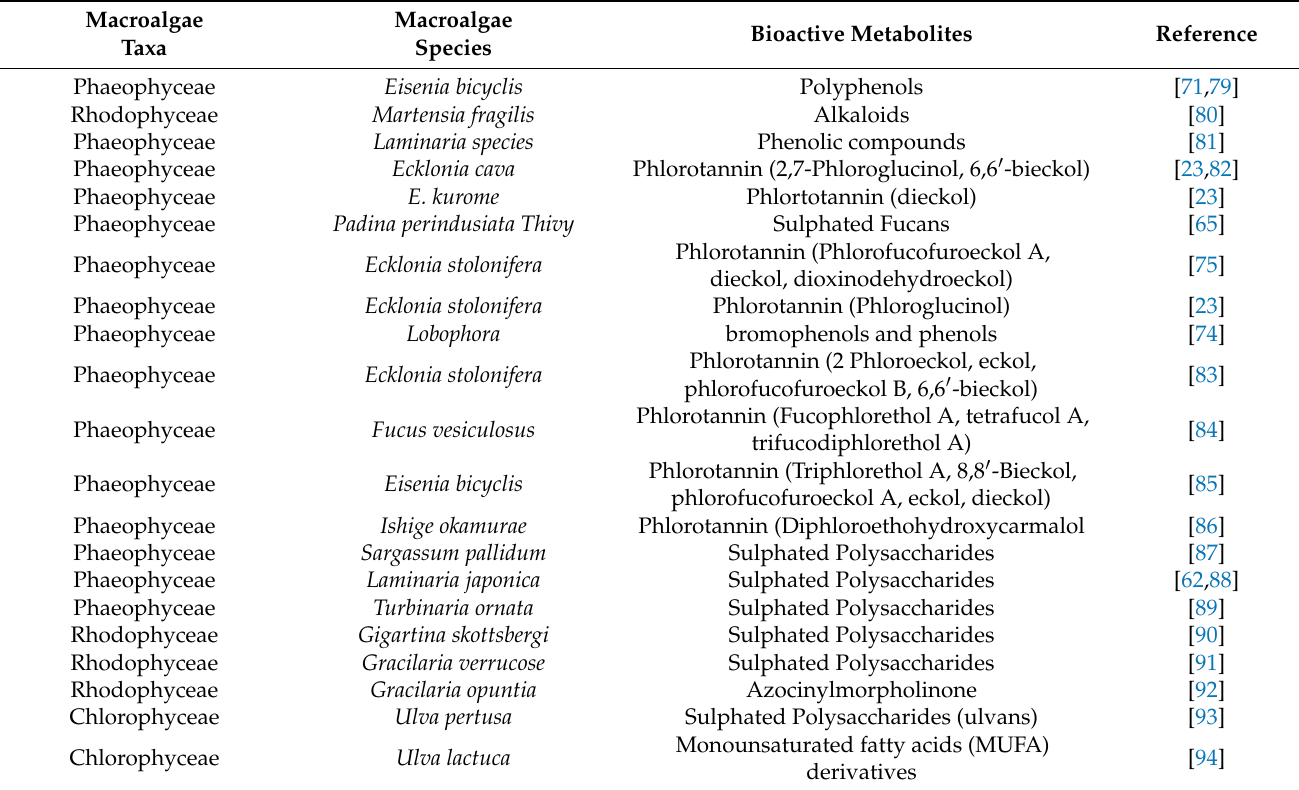
Table 4. A review of antioxidant properties of different macroalgae